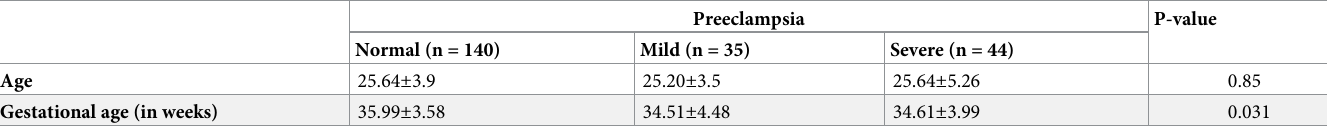
Table 1. Clinical characteristics of pregnant women with and without PE at ACSH and MGH, Mekelle, Ethiopia, from January–March 2017 (n =